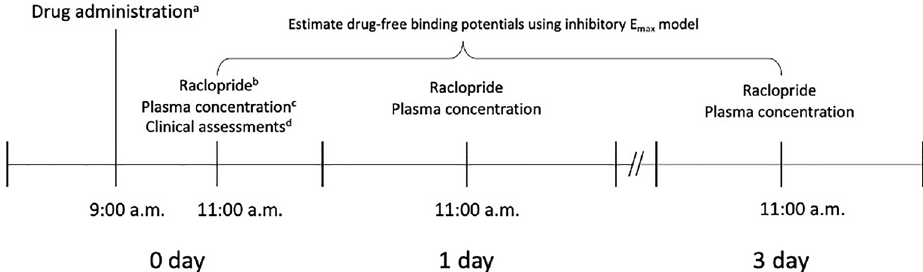
Figure 2. Diagram illustrating study protocol. ( a ) Aripiprazole; ( b ) positron emission tomography scan with [ 11 C]raclopride; ( c ) plasma concentration of aripiprazole; ( d ) clinical assessments with Positive and Negative Syndrome scale, Korean version of subjective well-being under Neuroleptics Scale-Short form, Simpson-Angus Scale, Abnormal Involuntary Movement Scale, and Barnes Akathisia Rating